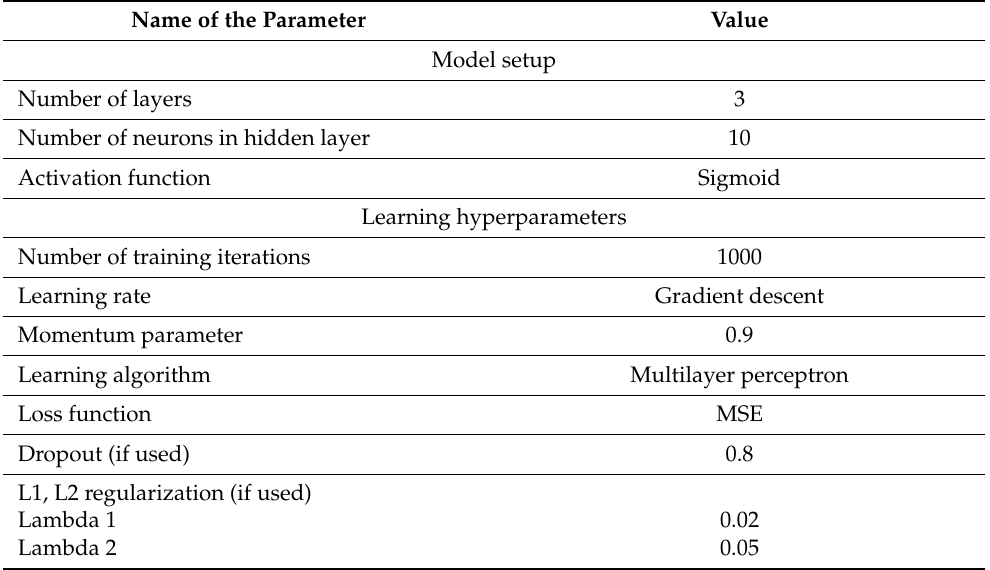
Table 5. Optimal parameter settings of the artificial neural network and the learning algorithm (MLP